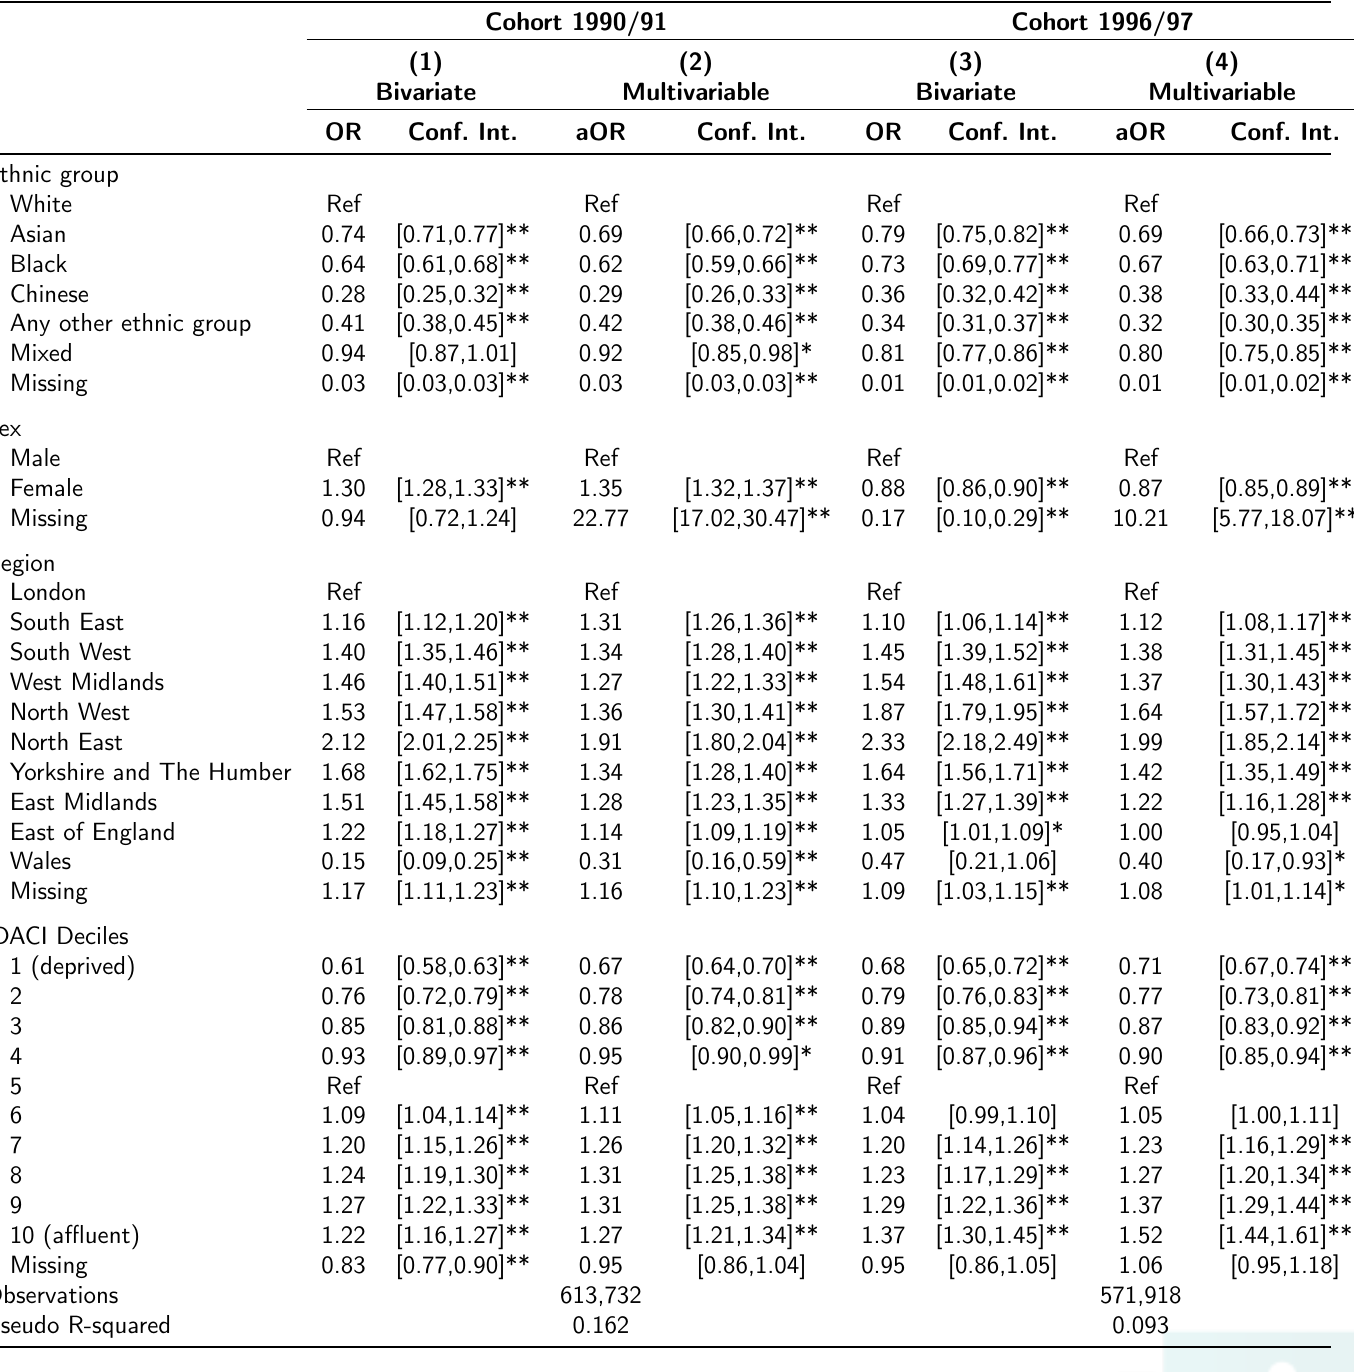
Supplementary Table 10: Odd Ratios (OR) and adjusted Odd Ratios (aOR) for linkage to HES by